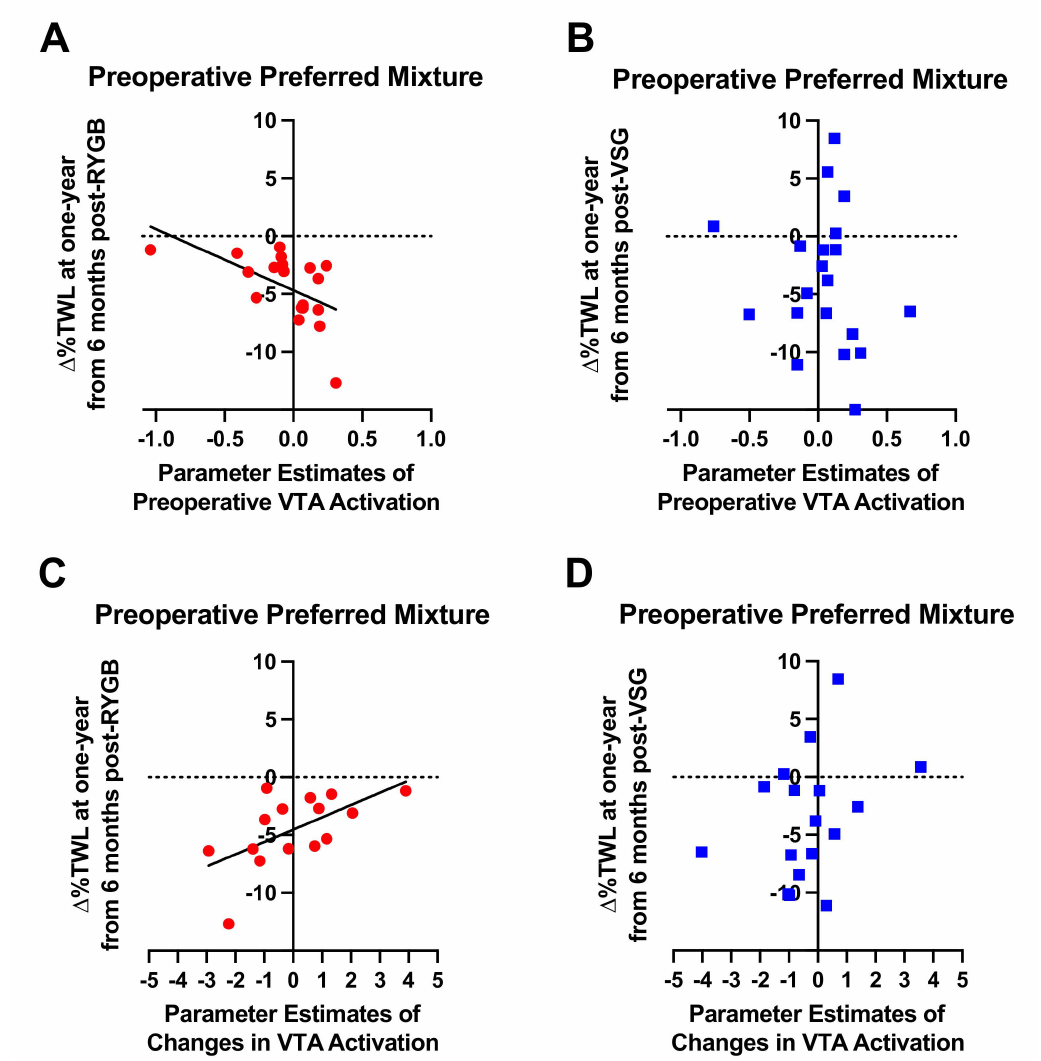
Figure 6. Relationship between preoperative VTA activation in response to the patient-specific preferred mixture delivered in the MRI scanner and ∆ %TWL from six months to one year in patients who received ( A ) RYGB (red circles) and ( B ) VSG (blue squares). Relationship between changes in preoperative VTA activation at 2 weeks following surgery relative to baseline in response to the patient-specific preferred mixture delivered in the MRI scanner and ∆ %TWL from six months to one year in patients who received ( C ) RYGB (red circles) and ( D ) VSG (blue squares). Line of best fit represents significant